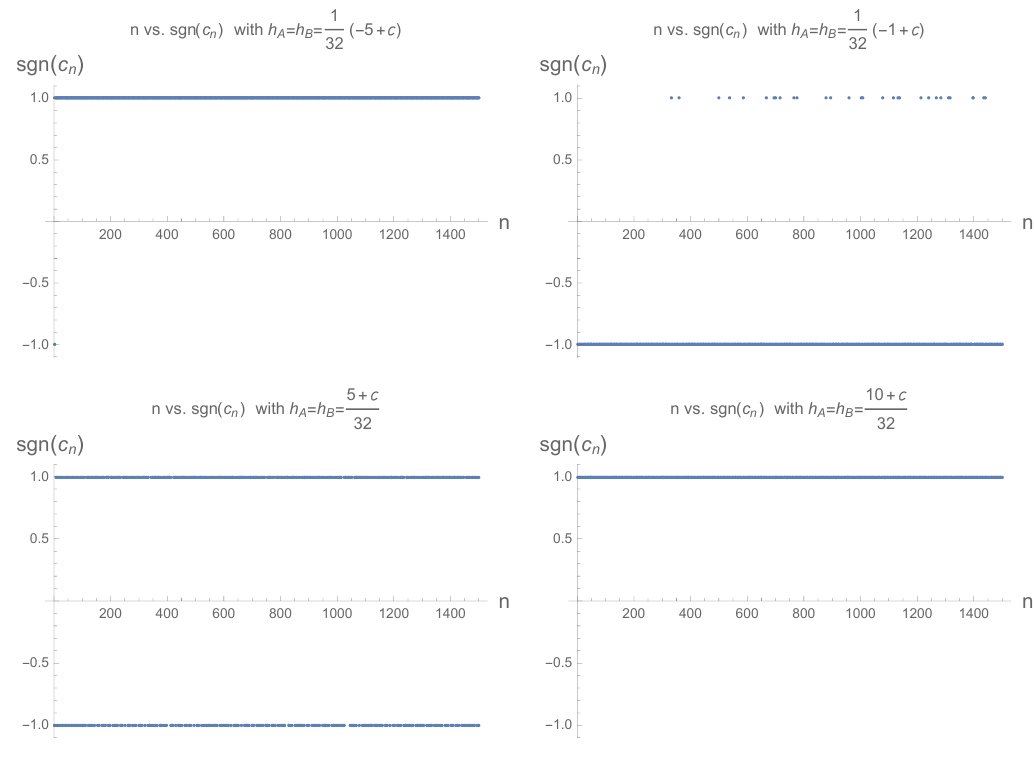
, and c +10 with c = 30 . , c − 1 , c +5 32 32 32 32